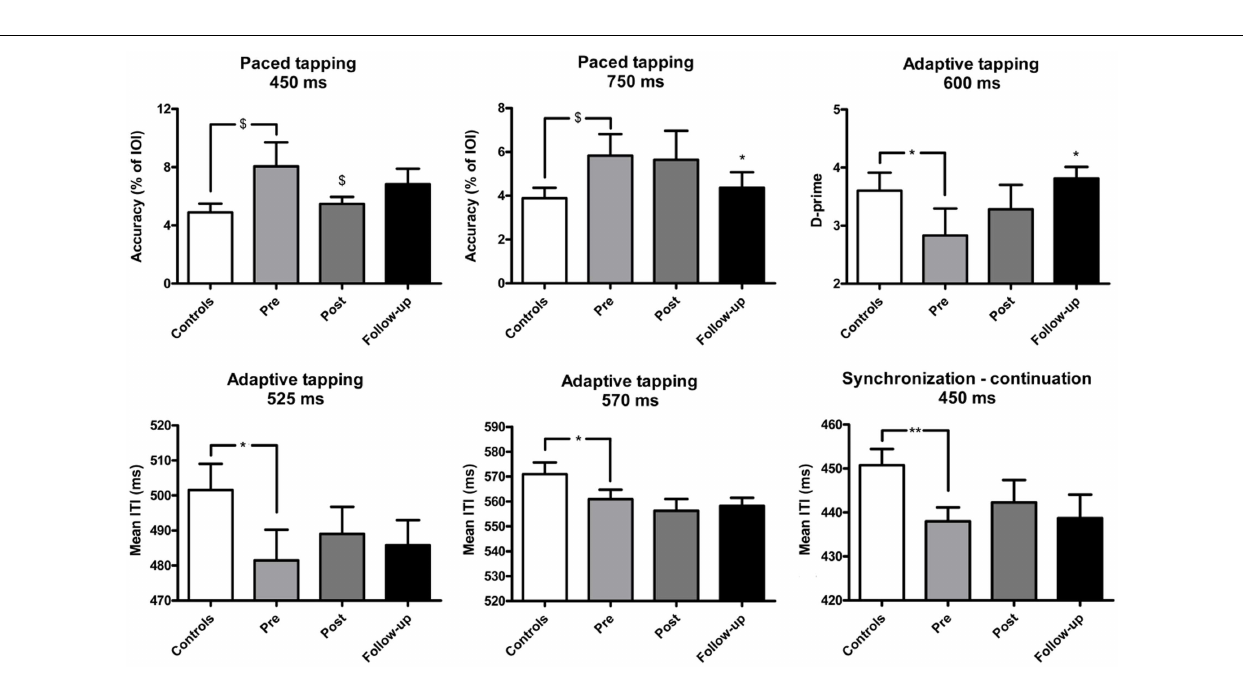
(IPD: M = 0.05, SEM = 0.08; controls: M = 0.05, SEM = 0.004). In paced tapping tasks, patients tended to be less accurate than controls when synchronizing with an isochronous sequence, a